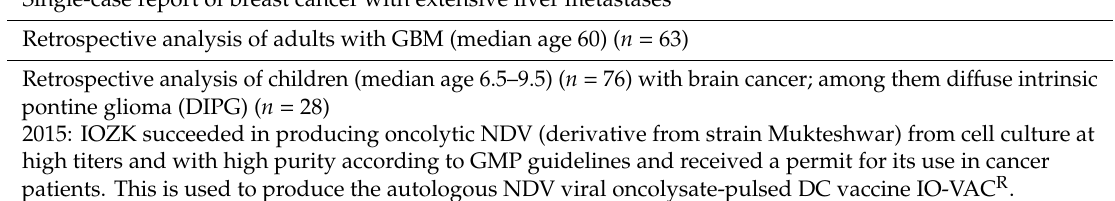
Table 4. Clinical application of NDV (Part II): Multimodal cancer immunotherapy combining hyperthermia / NDV pretreatment with active-specific vaccination via IO-VAC R . Single-case Report of Prostate Cancer with Extensive Bone Metastases Single-case report of breast cancer with extensive liver metastases Retrospective analysis of adults with GBM (median age 60) ( n = 63) Retrospective analysis of children (median age 6.5–9.5) ( n = 76) with brain cancer; among them di ff use intrinsic pontine glioma (DIPG) ( n = 28) 2015: IOZK succeeded in producing oncolytic NDV (derivative from strain Mukteshwar) from cell culture at